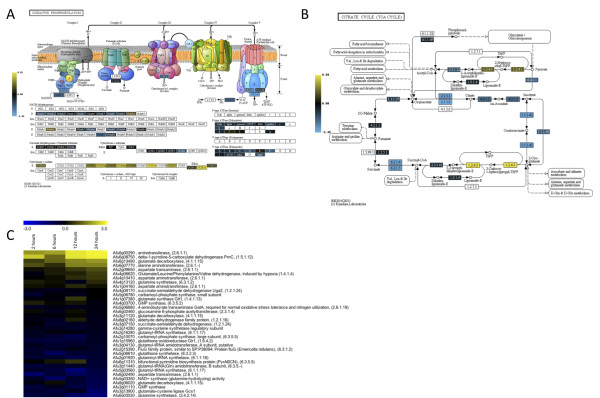
Hypoxia affects transcript levels of enzymes involved in the tricarboxylic acid (TCA) cycle, oxidative phosphorylation, glutamate biosynthesis and the GABA shunt. A. KEGG heat map representation of genes involved oxidative phosphorylation comparing transcript levels at the indicated times after exposure to hypoxic conditions to time point immediately prior to hypoxia exposure (0 hours). Yellow indicates transcript level is higher. Scale on left indicates intensity of expression. B. KEGG heat map representation of genes involved in the TCA cycle, comparing transcript levels at the indicated times after exposure to hypoxic conditions to time point immediately prior to hypoxia exposure (0 hours). Yellow indicates transcript level is higher. Scale on left indicates intensity of expression. C. Heat map representation of transcripts involved in glutamate biosynthesis, including transcripts associated with the GABA shunt. Both heat maps compare wild type Aspergillus fumigatus strain CBS144.89 at the indicated times after exposure to hypoxic conditions to time point immediately prior to hypoxia exposure (0 hours). Yellow indicates transcript level is higher, and values are sorted by the 24-hour time point.